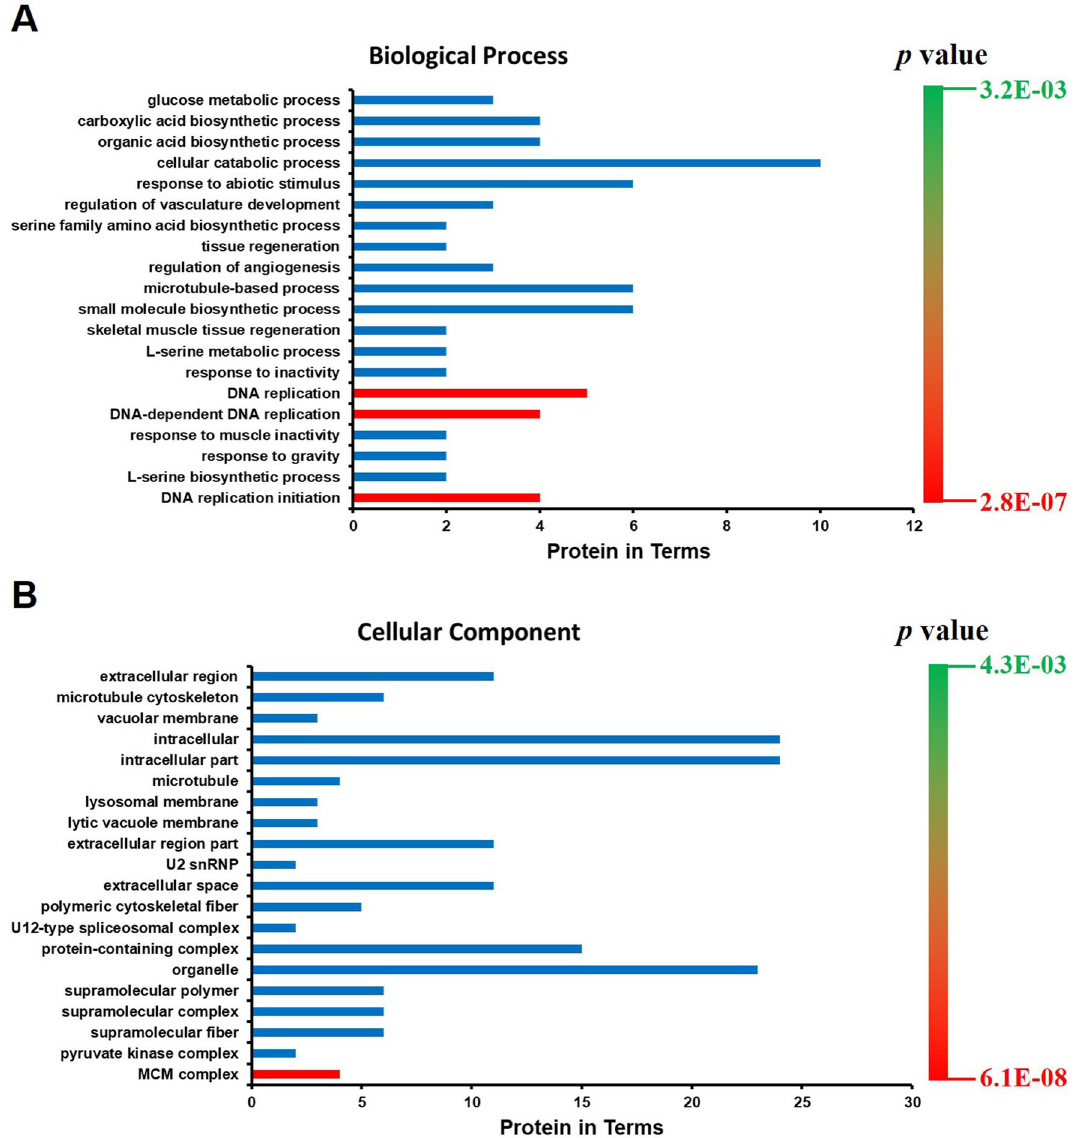
Figure 2. GO analysis of identified proteins downregulated in VPS35-depleted HeLa cells. GO analysis was performed according to biological process ( A ) and cellular component ( B ) by the PANTHER classification system. Red bars represent the DNA replication-related biological process ( A ) or cellular component ( B